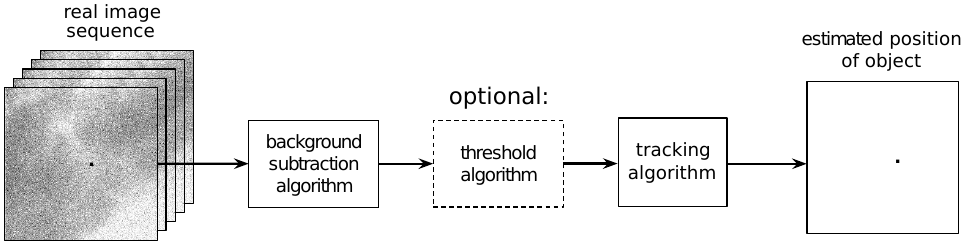
Figure 9. Tracking pipeline with background